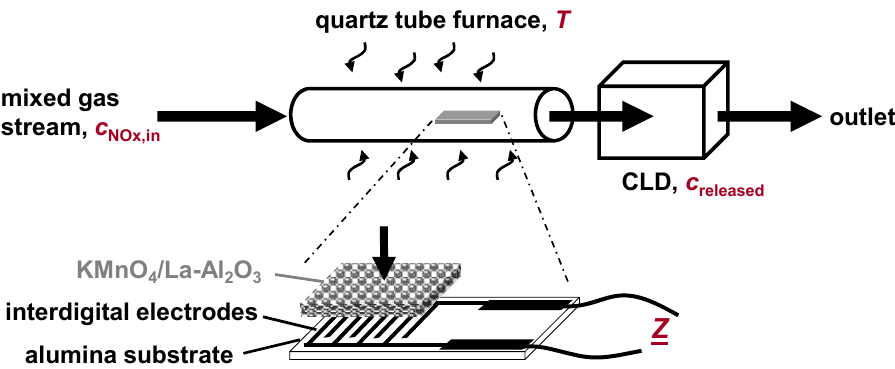
Figure 2. Sensor setup and test apparatus including the gas dosing system, a quartz tube furnace containing the KMnO (CLD, 700 EL ht,